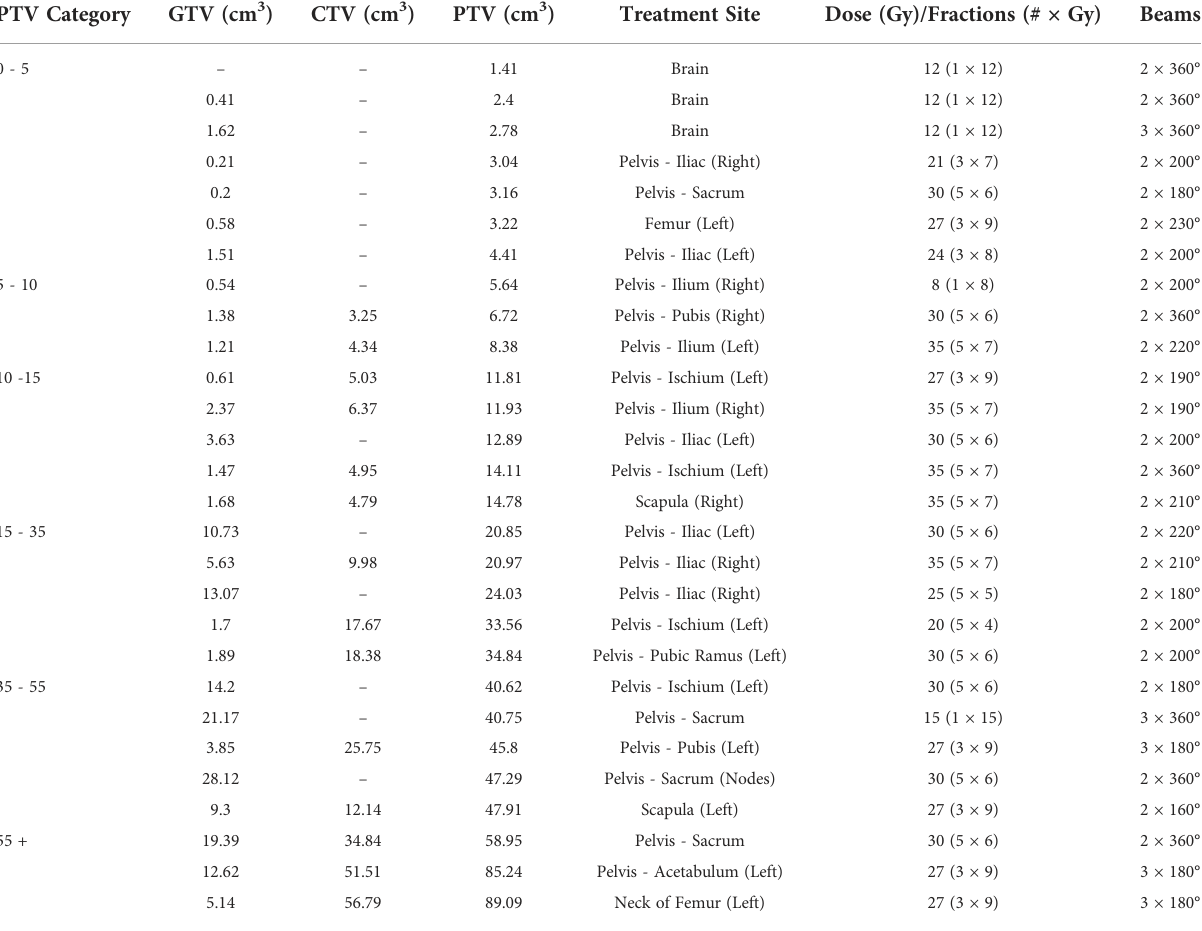
TABLE 1 Summary of all plans used in this study and their key characteristics grouped by PTV size. PTV